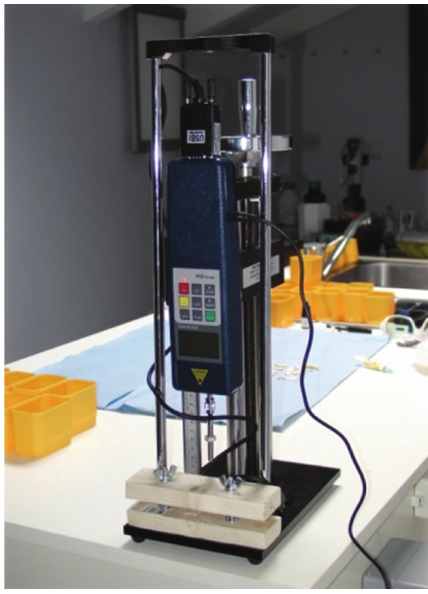
Figure 2: Dynamometer used to make the compression tests.